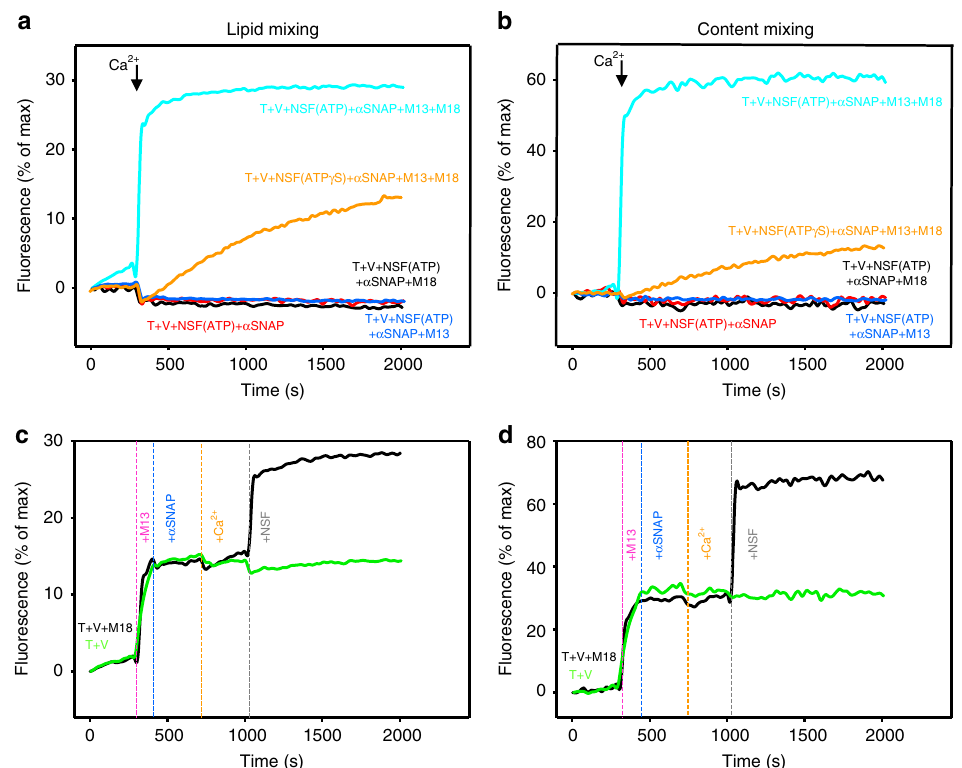
Fig. 4 NSF rescues the inhibition of fusion between V- and T-liposomes caused by α SNAP. a , b Lipid mixing ( a ) between V- and T-liposomes was monitored from the fl uorescence de-quenching of Marina Blue lipids and content mixing ( b ) was monitored from the increase in the fl uorescence signal of Cy5-streptavidin trapped in the V-liposomes caused by FRET with PhycoE-biotin trapped in the T-liposomes upon liposome fusion. Assays were performed in the presence of 0.8 µ M NSF and 2 µ M α SNAP without or with 1 µ M Munc18-1 (M18) and/or 0.5 µ M M13C 1 C 2 BMUNC 2 C (M13) as indicated by the color- coded labels. All traces were acquired with NSF in the presence of ATP, except the orange traces, where ATP was replaced by ATP γ S. Experiments were started in the presence of 100 μ M EGTA, 1 µ M excess of SNAP-25, and 5 μ M streptavidin, and Ca 2 + (600 μ M) was then added at 300 s. c , d Analogous assays where reagents were added sequentially. Experiments were started in the presence (black trace) or absence (green trace) of 1 µ M Munc18-1; 0.5 µ M M13C µ M α SNAP, 600 µ M Ca 2 + , and 0.8 µ M NSF were added at the indicated time points. Note that, in the presence of 1 C 2 BMUNC 2 C, 2